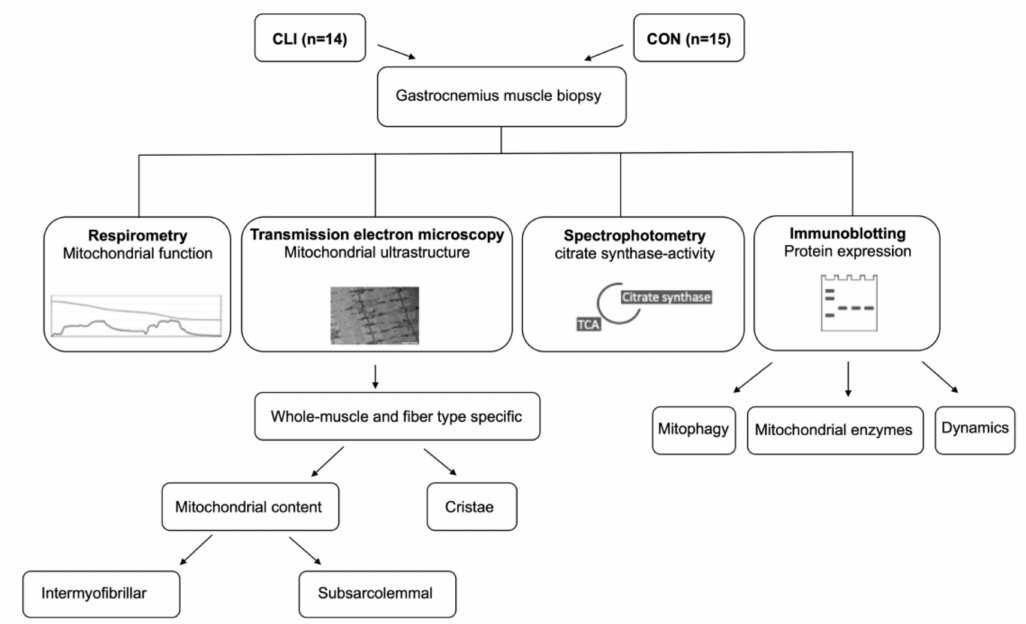
Figure 1. Experimental overview. Muscle biopsies were collected from 14 critical limb ischemia (CLI) patients and 15 control (CON) patients. Mitochondrial respiratory function was analyzed with high-resolution respirometry. Mitochondrial volumetric content and cristae surface area density were analyzed in whole muscle and stratified by fiber type with transmission electron